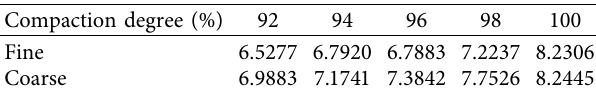
Table 2: Average dielectric constant of specimens with both gradation types and various compaction degrees.